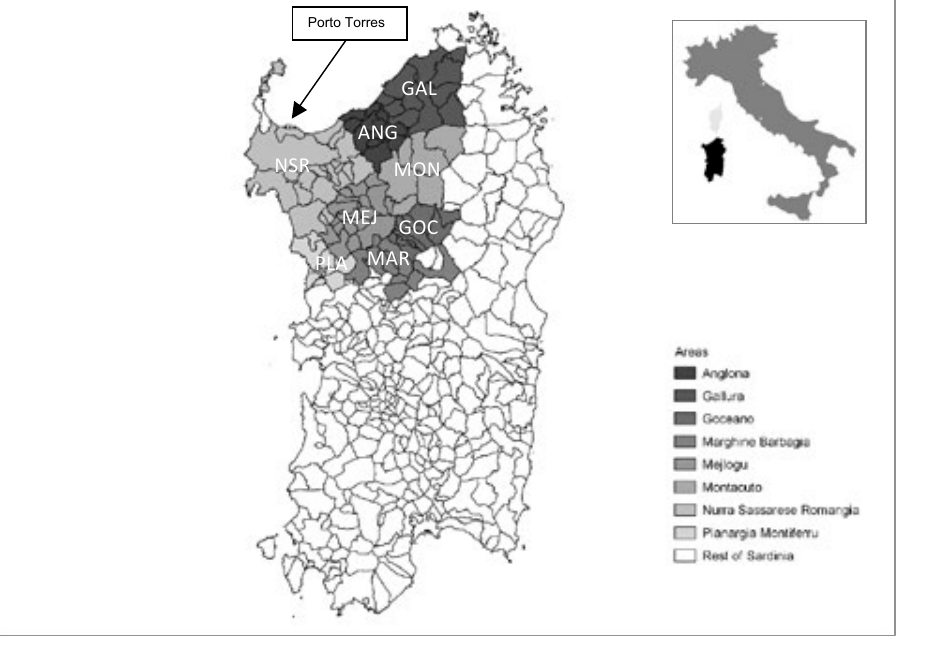
Table 1. Main socio-economic indicators of the local districts involved in the project, Sardinia, Italy. District